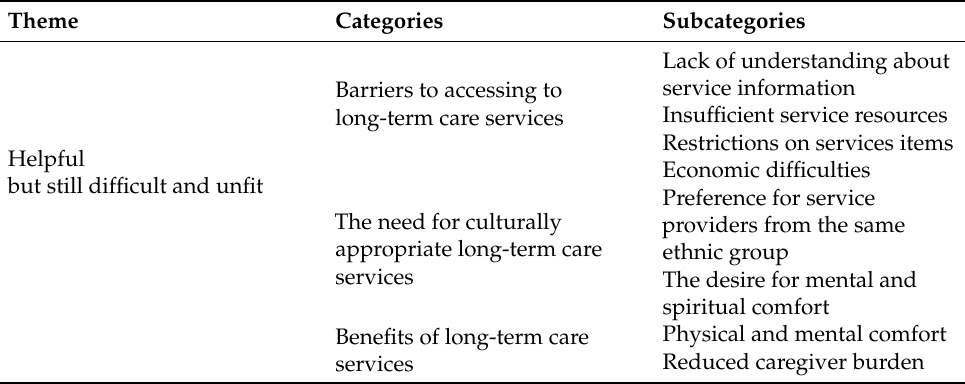
Table 2. An overview of theme, categories, and